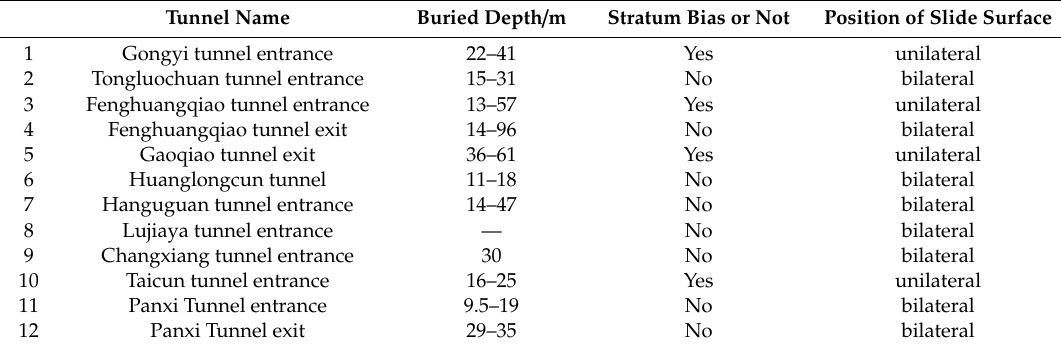
Table 3. Statistics of the stratum bias and the location of the slide surface.